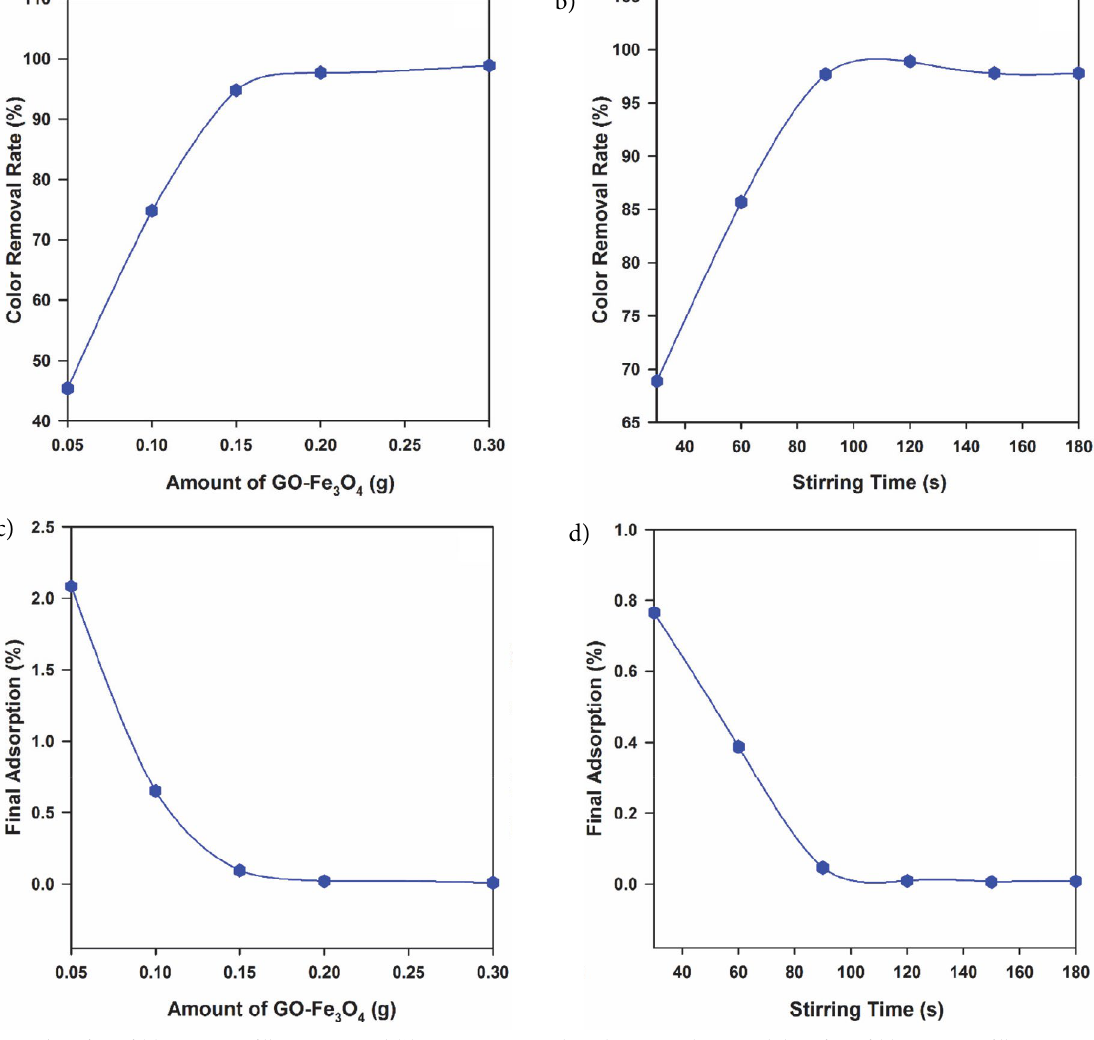
Figure 4. The effect of (a) magnetite filler content and (b) stirring time on the color removal rate; and the effect of (c) magnetite filler content and (d) stirring time on the final adsorption of Erythrosine